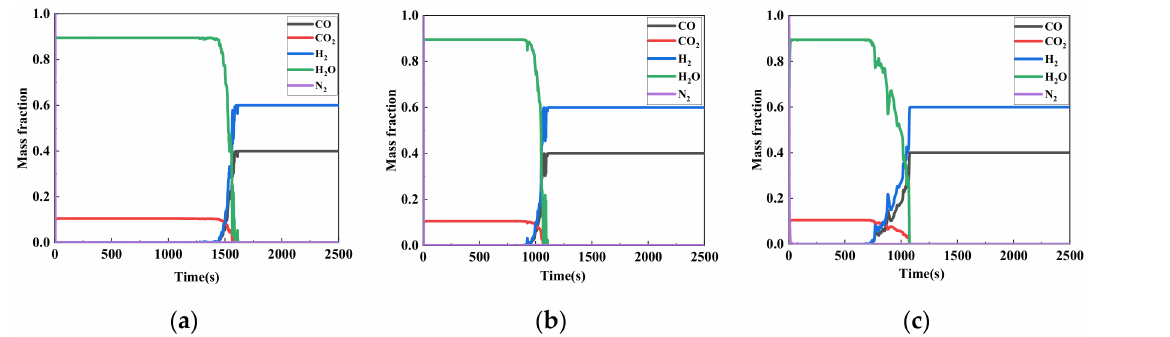
Figure 11. Changes in gas composition over time. ( a ) Experiments 13. ( b ) Experiments 14. ( c ) Experiments 15.